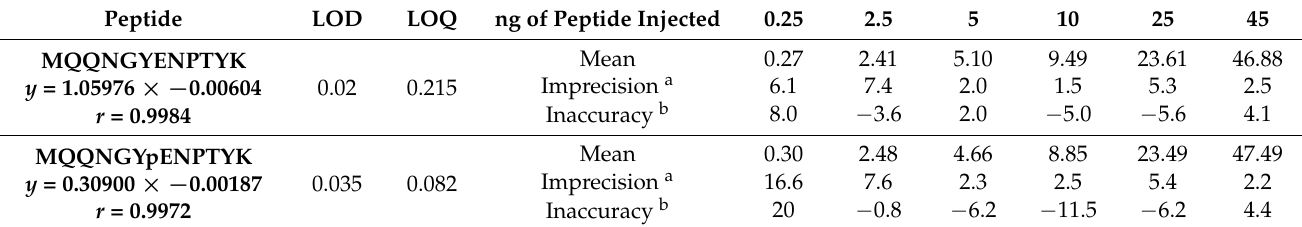
Quality control samples were analyzed after a sequence of unknown samples. Two lev- els of QC samples were prepared to evaluate imprecision and inaccuracy of the